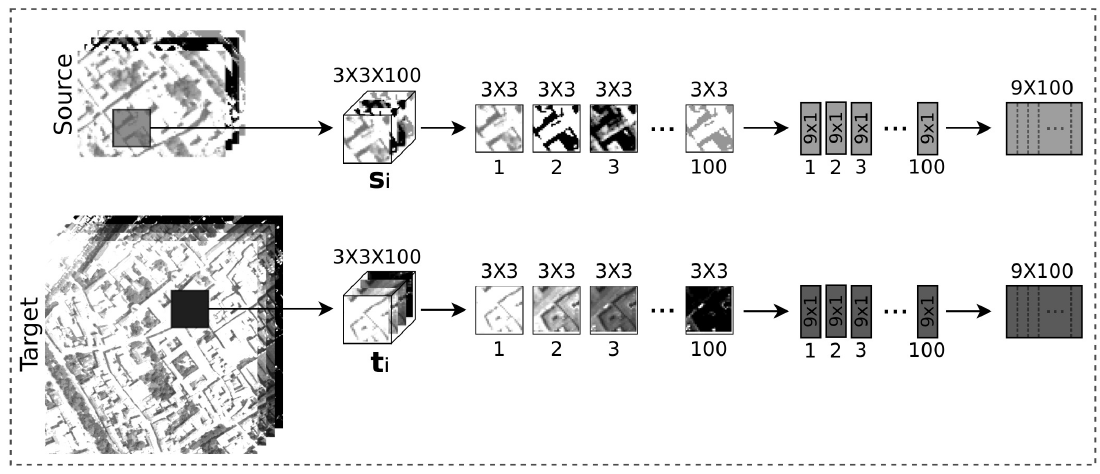
Figure 4. Patch extraction example for a case of D × D × B patches, being D = 3 and B =